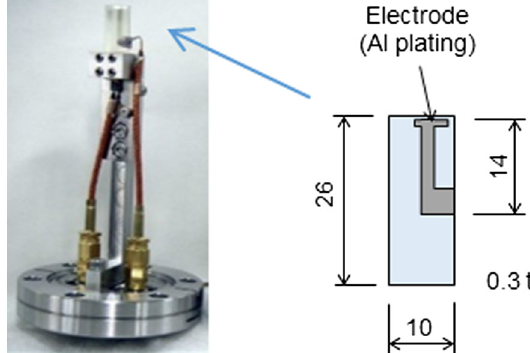
FIG. 7. Schematic of the detection element (right) and entire structure of the detection element including the ICF70 flange (left) developed as an electron beam halo monitor.